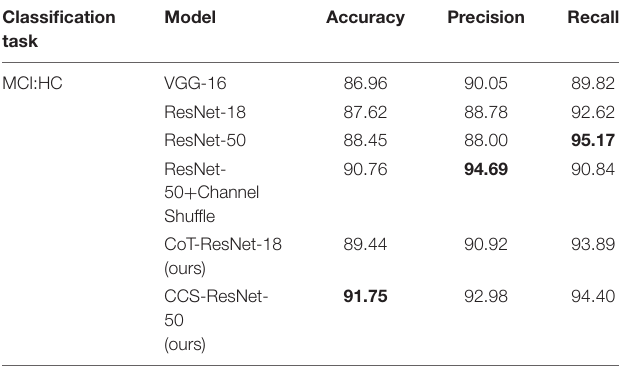
TABLE 7 | Experimental results of AD:MCI:HC classification on MRI slices (unit: %). Classification task